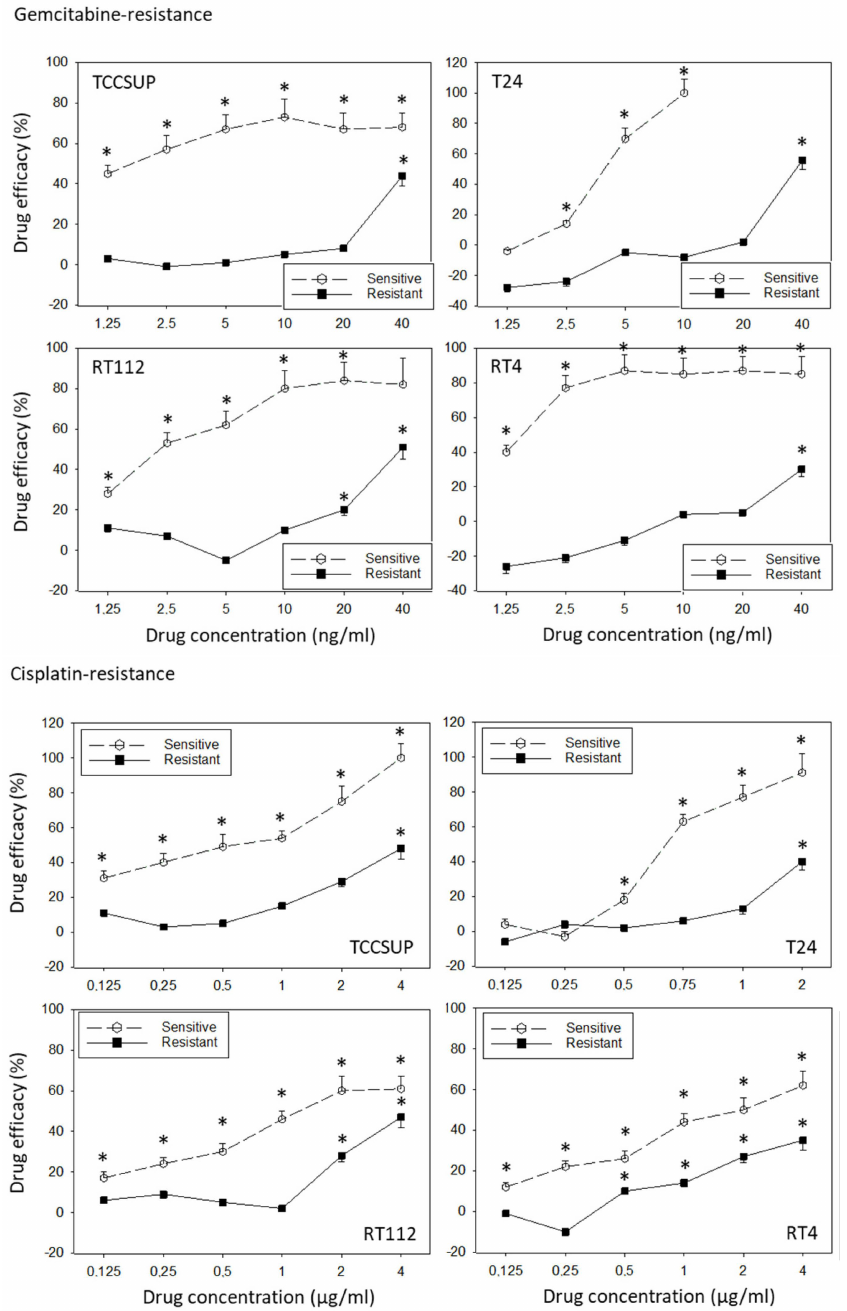
Figure 1. Response of sensitive versus resistant TCCSUP, T24, RT112, and RT4 bladder cancer cell lines to gemcitabine (upper graphs) and cisplatin (lower graphs). Cell lines were exposed to the compounds, the cell number was evaluated after 24, 48, and 72 h using the MTT assay, and the 24–72 h increase was determined. Differences between the cell number increase of drug-treated and non-treated (control) cells are presented as percentage drug efficacy, indicating a percentage cell number reduction. Negative values indicate an increase in the cell number under drug treatment, compared to the control. The 24–72 h cell growth data are shown in the Supplementary Materials (Figure S1). Error bars indicate the standard deviation. * indicates a significant reduction in the tumor cell number, compared to the corresponding control, n = 6.